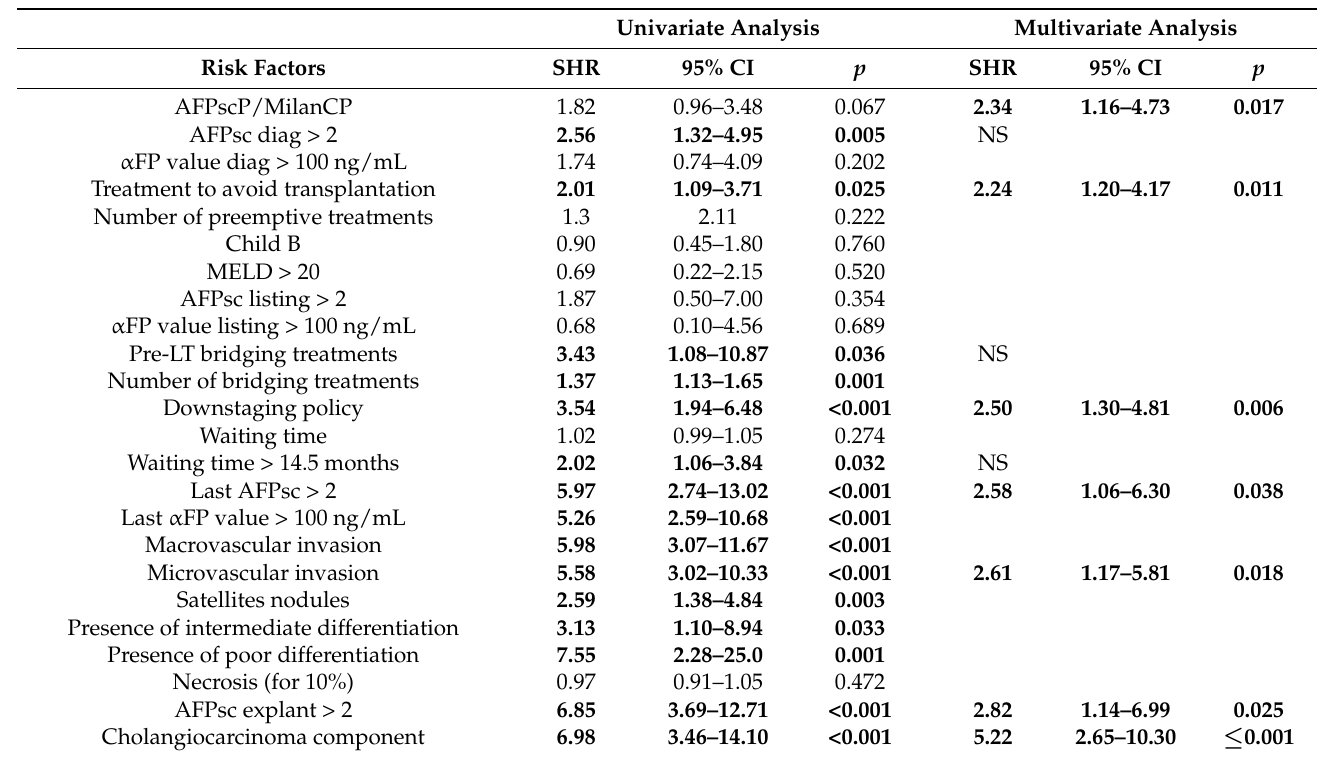
Table 5. Risk factors for tumor recurrence: univariate and multivariate analyses (n = 364). Univariate Analysis Multivariate